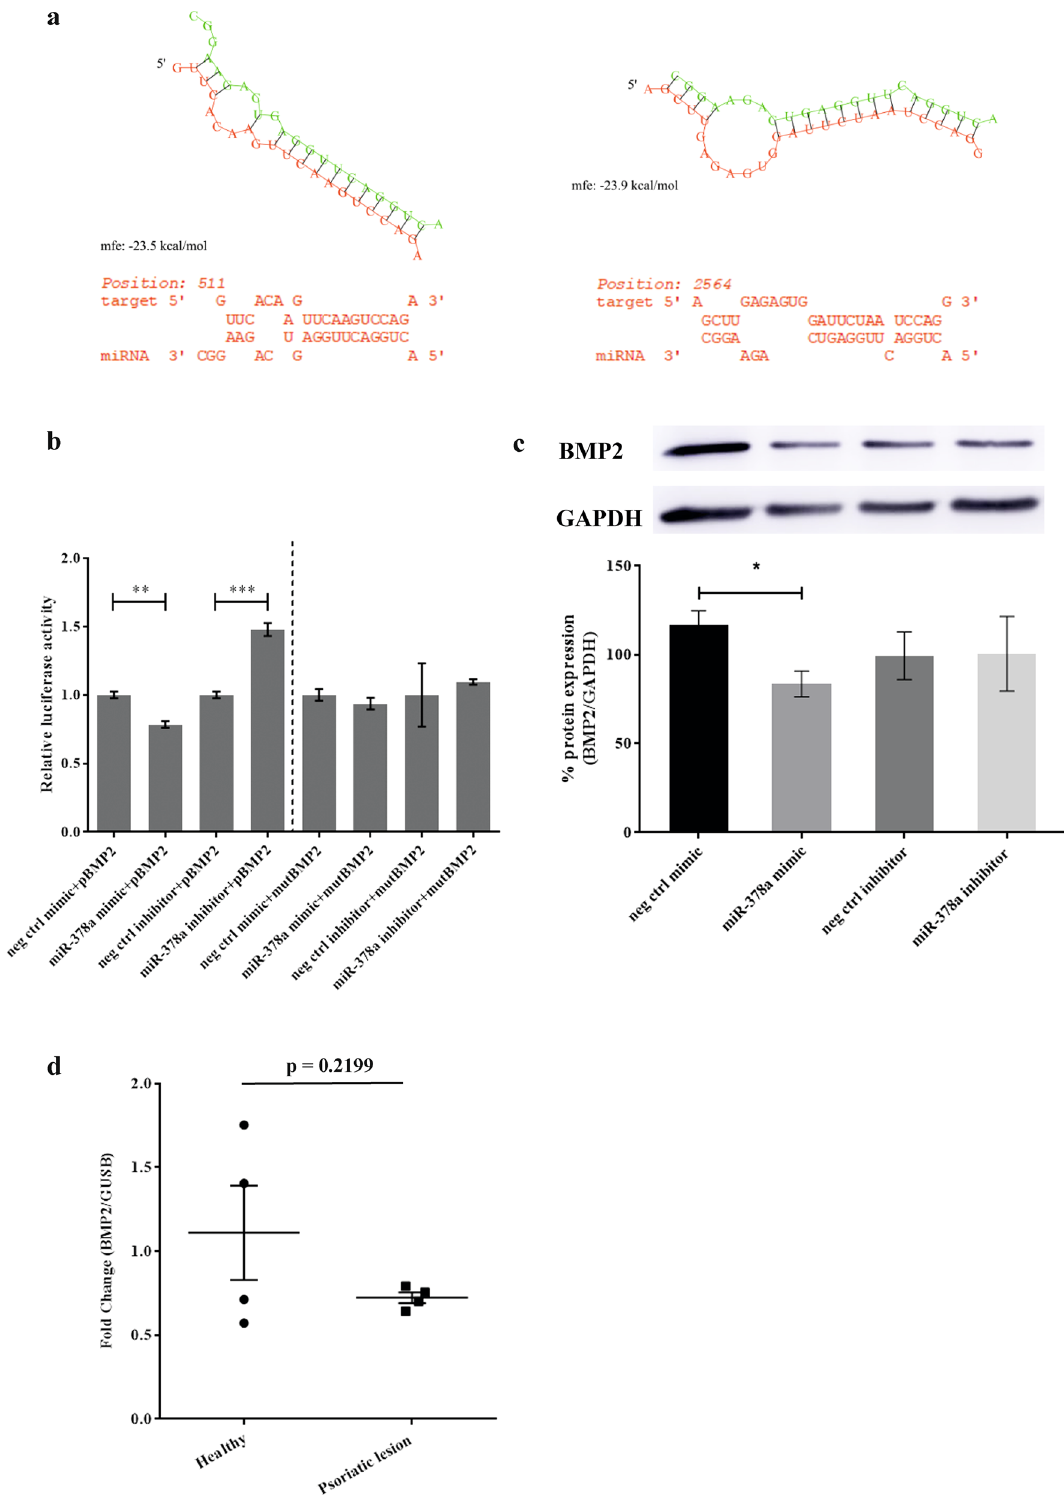
Figure 7. BMP2 as a novel target gene of miR-378a in keratinocytes. ( a ) Hypothetical binding structure of miR- 378a at 3 ′ UTR of BMP2 (left) and INHBA (right) with predictive binding energy and probability value for actual binding. ( b ) Luciferase activity of wild-type and mutant 3 ′ UTR of BMP2 genes in HEK293T cells co-transfected with miR-378a mimic or inhibitor for 48 h. ( c ) Western blot images (top) and quantitative measurement (bottom) of BMP2 protein in NHEK cells with miR-378a overexpression or suppression for 72 h. A representative image of BMP2 protein from four independent experiments was shown (also see Supplementary Fig. S5). ( d ) The expression level of BMP2 in psoriatic lesions (n = 4) and healthy individuals (n = 4). *Indicates P < 0.05, **indicates P < 0.01, and ***indicates P <